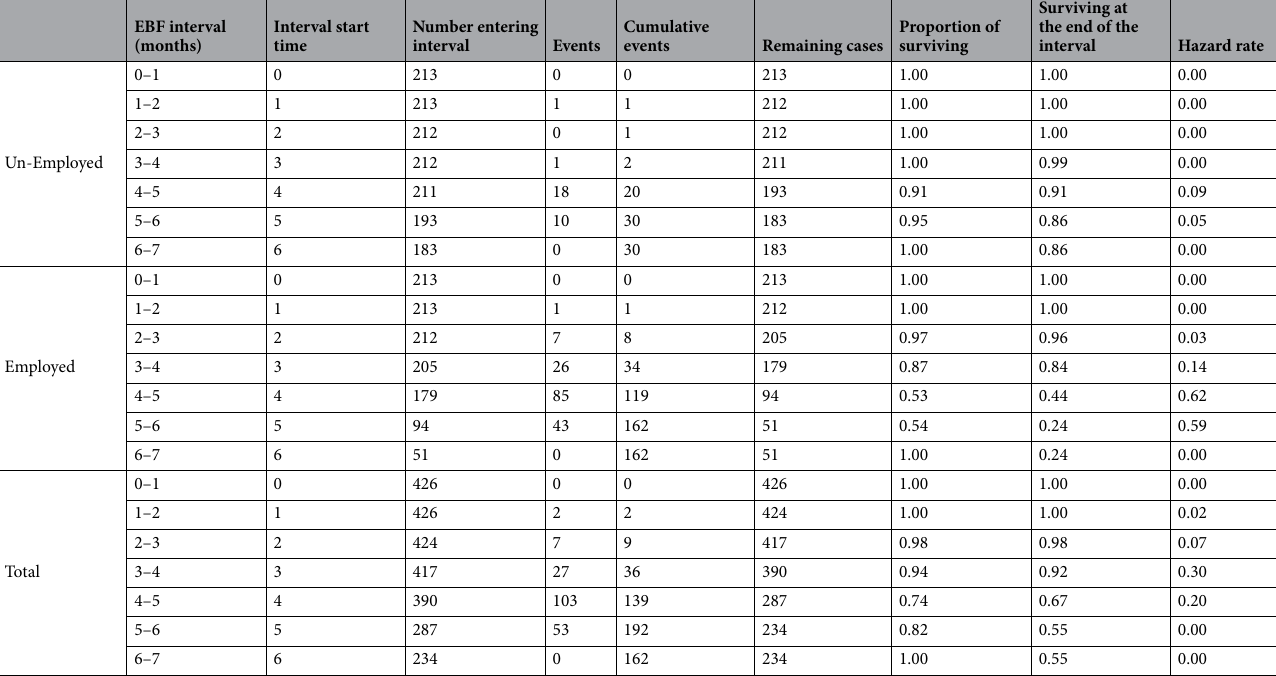
Table 5. Life table for exclusive breastfeeding duration for 6–12 months’ age children of employed and unemployed mothers at Debre tabor Town, Northwest Ethiopia,